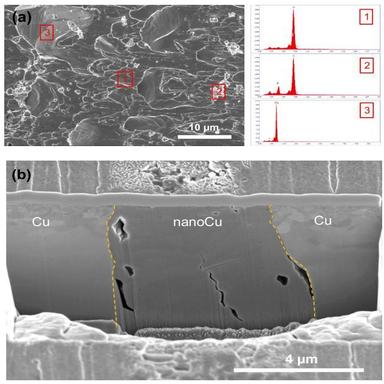
(a) SEM image and EDS spectra, and (b) cross-sectional morphology of the sintered Cu/nanoCu/Cu joints after thermal aging at 500 ◦C for 100 h.